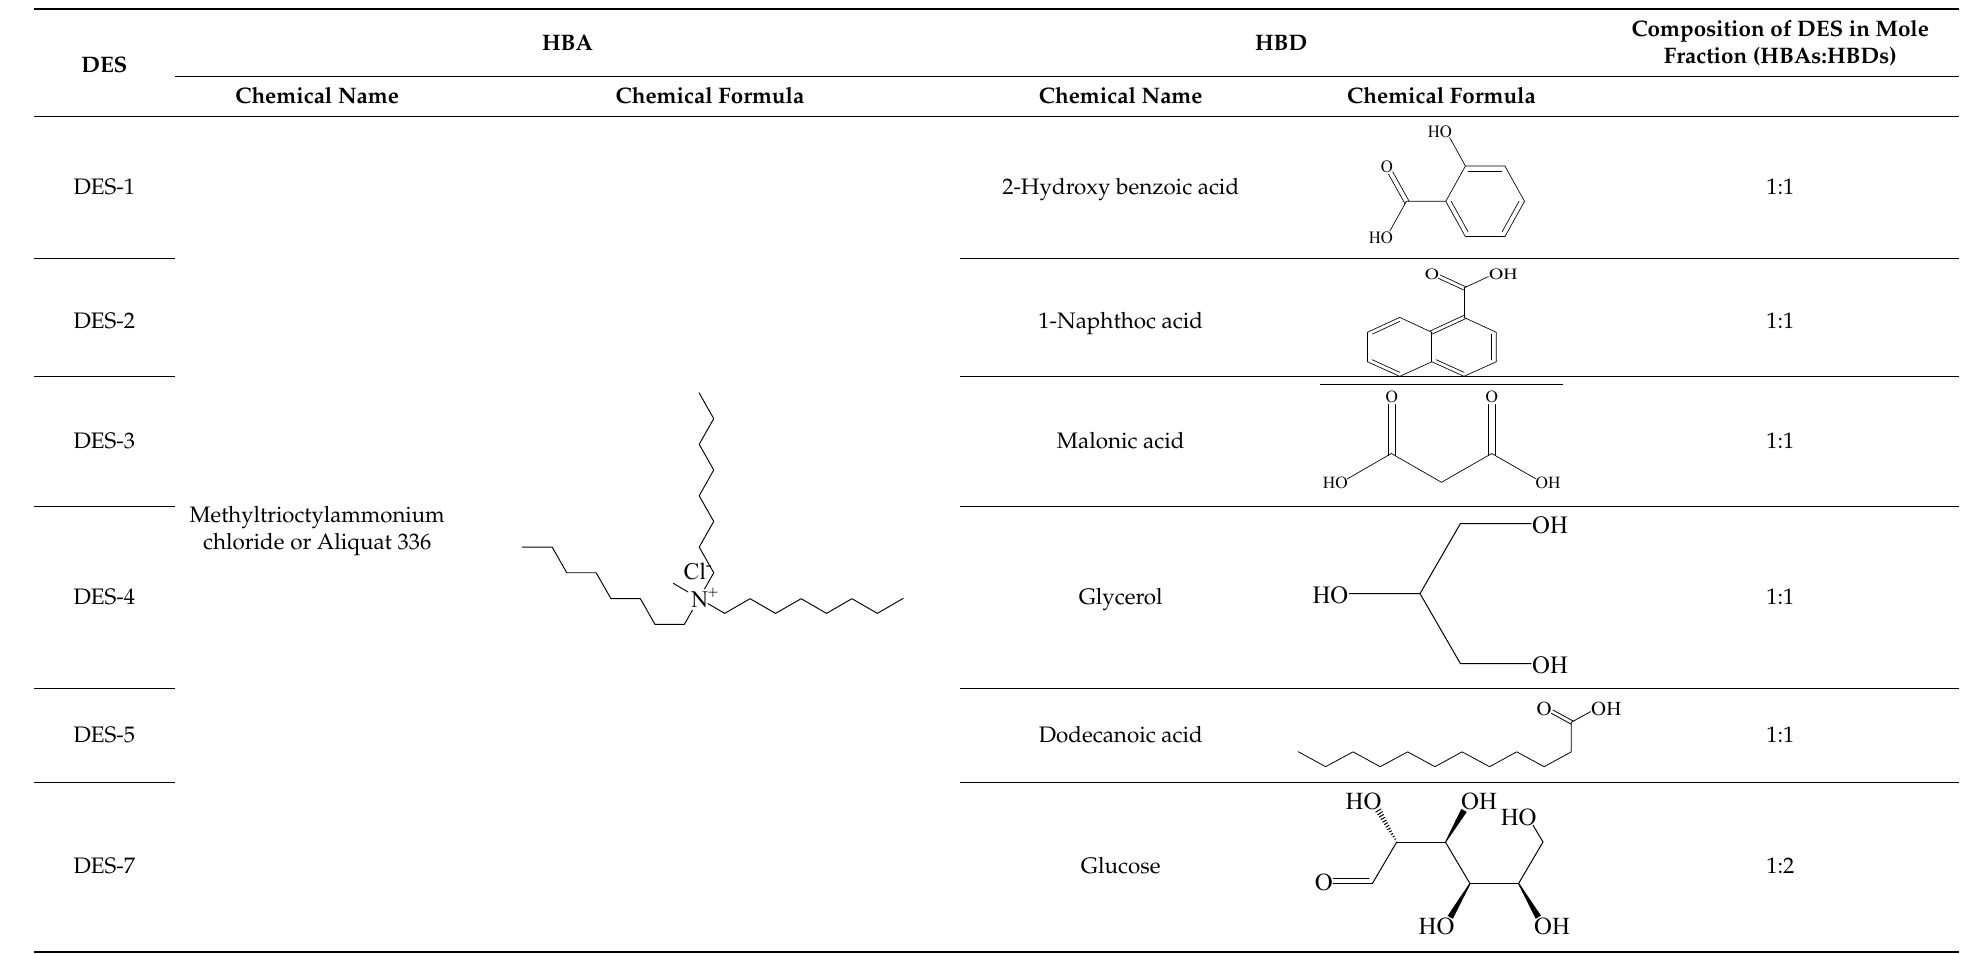
Table 1. Deep eutectic solvents, their structures, and molar ratios.